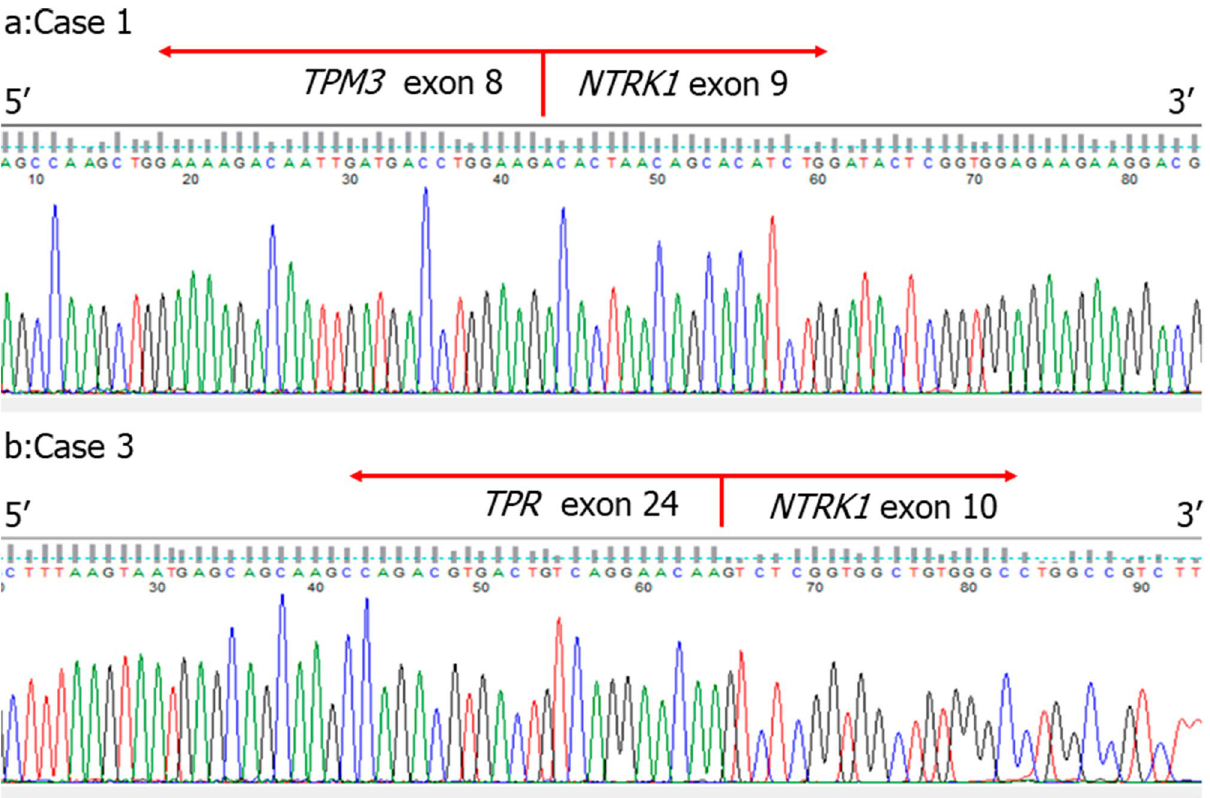
Figure 3. RT-PCR was performed to confirm the findings of the Archer analysis. Subsequent Sanger sequencing revealed TPM3 (exon8)- NTRK1 (exon9) in Cases #1 and #2, and TPR (exon24)- NTRK1 (exon10) in Case #3.